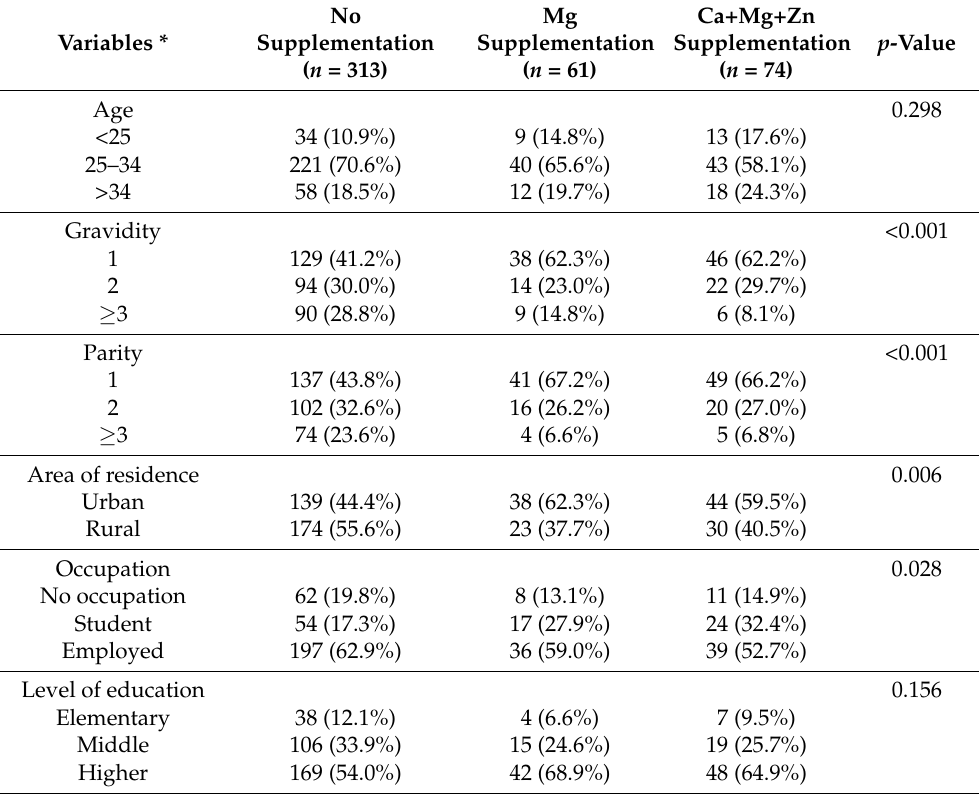
Table 1. Background data of the study cohort stratified by type of micronutrient